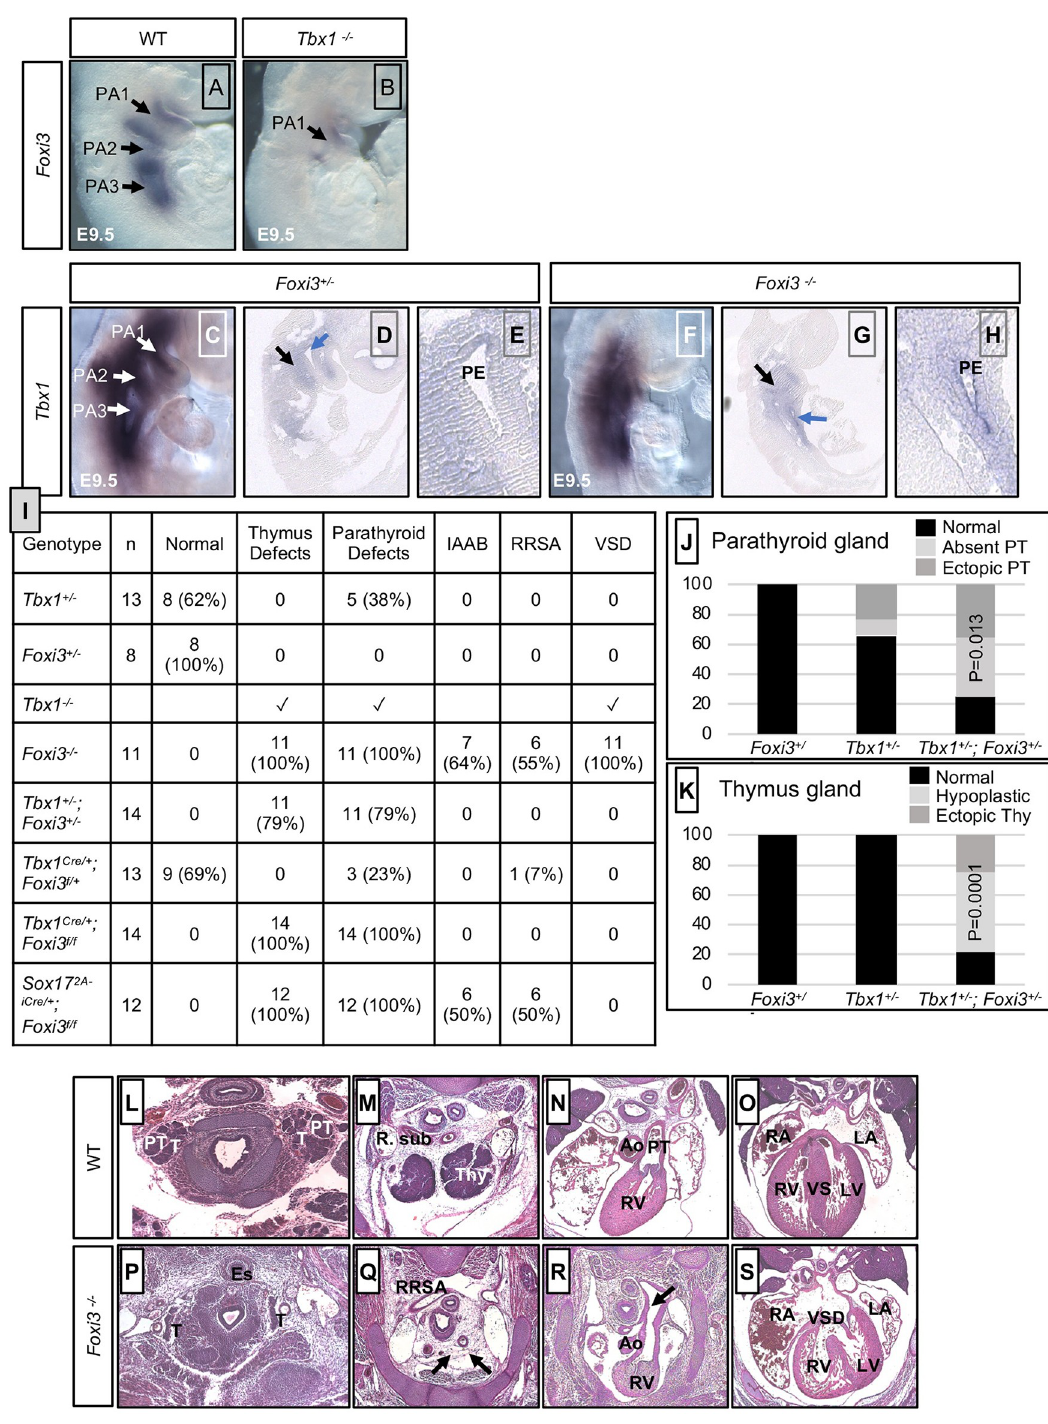
Fig 1. Tbx1 and Foxi3 genetically interact for thymus and parathyroid gland development. (A-B) Whole mount in situ hybridization (WMISH) using an antisense Foxi3 probe on wildtype (WT; A) and Tbx1 -/- mouse embryos at E9.5 (B); n = 3 for each genotype. Individual pharyngeal arches, PA1, PA2 and PA3 are indicated and the arrows point to the corresponding arch. (C-H) WMISH using an antisense Tbx1 probe on whole mount and sagittal sections of control ( Foxi3 +/- ; C-E) and Foxi3 -/- (F-H) mouse embryos at E9.5 (n = 3 for each genotype). Black arrow indicates the core mesoderm and blue arrow indicates the endoderm. Zoomed in image of the pharyngeal pouch (E, H) next to the blue arrow (D, G), to demonstrate that Tbx1 is still expressed in the control and mutant embryos, respectively. Pharyngeal endoderm is indicated as PE. (I) Table summarizing defects found in each embryo with the genotype listed in the first column on the left. The second column indicates the number of embryos. The rest of